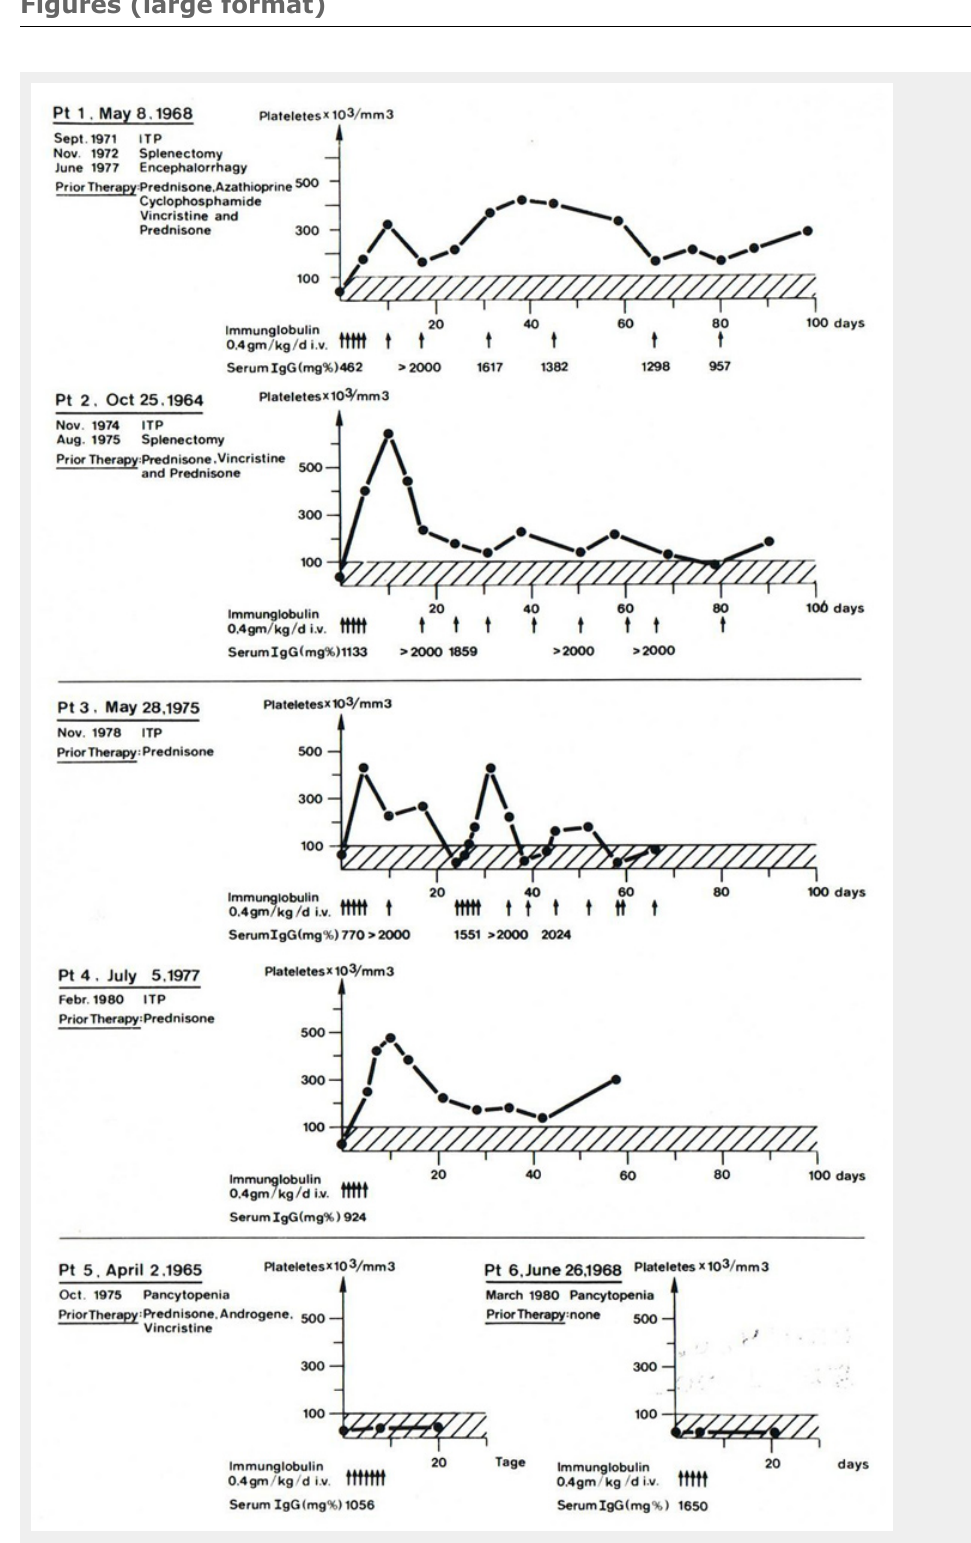
Figure 1 Pilotstudy 1 with controls. Response rate of IVIG during the first 80 days, 20 days respectively, of observation. Patient 1 is the key patient with ITP and secondary hypogammaglobulinaemia. Patients 2–4 with ITP, but with normal serum IgG levels. Patients 5 and 6 with aplastic anaemia and no response to IVIG. Arrow means 0.4 g IVIG per kilogram body weight/day. Serum IgG in mg% (© Imbach P, Barandun S, Baumgartner C, Hirt A, Hofer F, Wagner HP. High-dose intravenous immunoglobulin therapy of refractory, in particular idiopathic thrombocytopenia in childhood. Helv Paediat Acta. 1981;46:81–6. Reprinted with kind